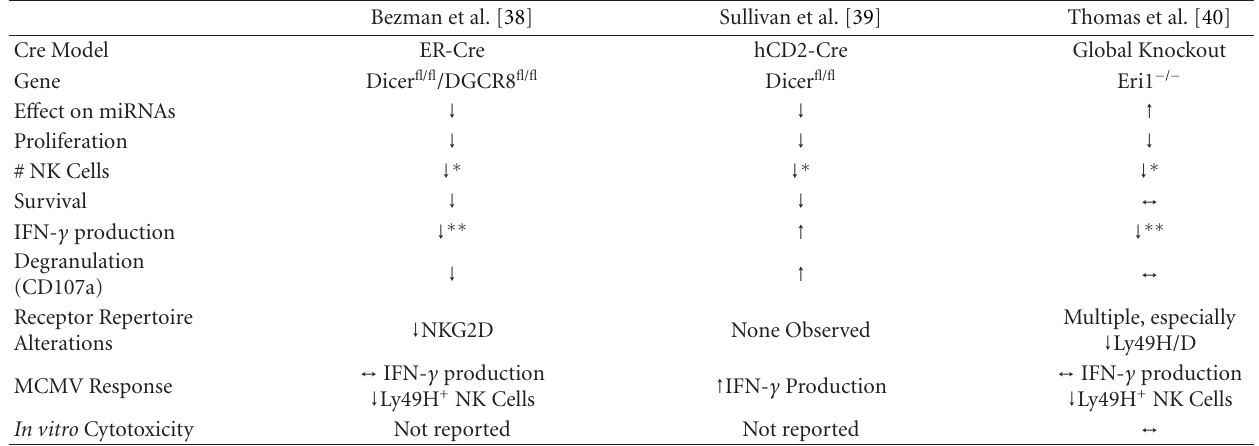
Table 3: Summary of global miRNA-deficient or over-expression (Eri1 − / − ) NK cells. ∗ In particular, at latest stages of NK cell maturation. ∗∗ In response to activating (ITAM) receptor-mediated